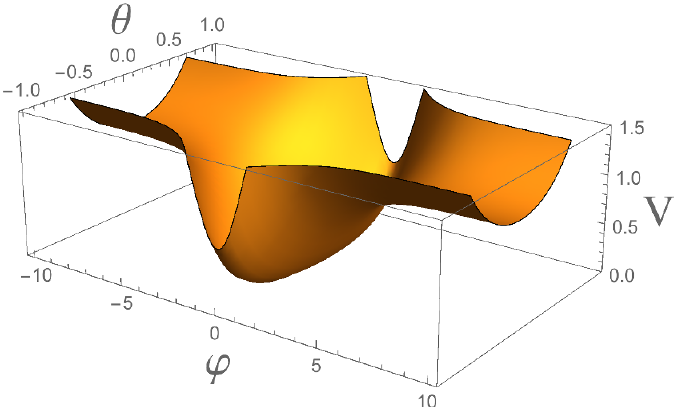
Figure 2 . Basic T-model with (cid:11) = 1. The height of the potential here and in other (cid:12)gures is in units m 2 and the values of the (cid:12)elds are in Planck mass